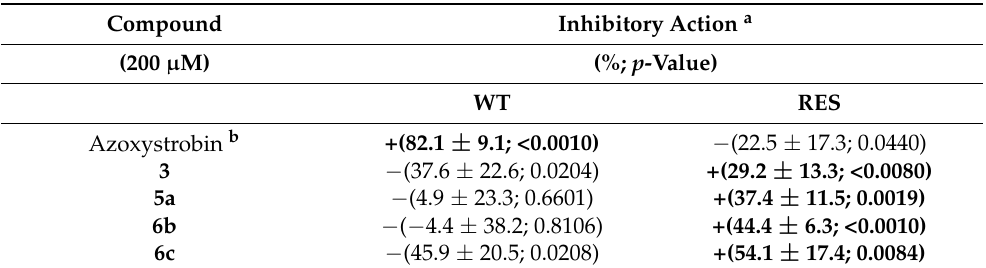
Table 2. Inhibitory action of a subset of compounds on the cyt bc1 function by measurements of the mitochondrial decylubiquinol:cyt c oxidoreductase activity.